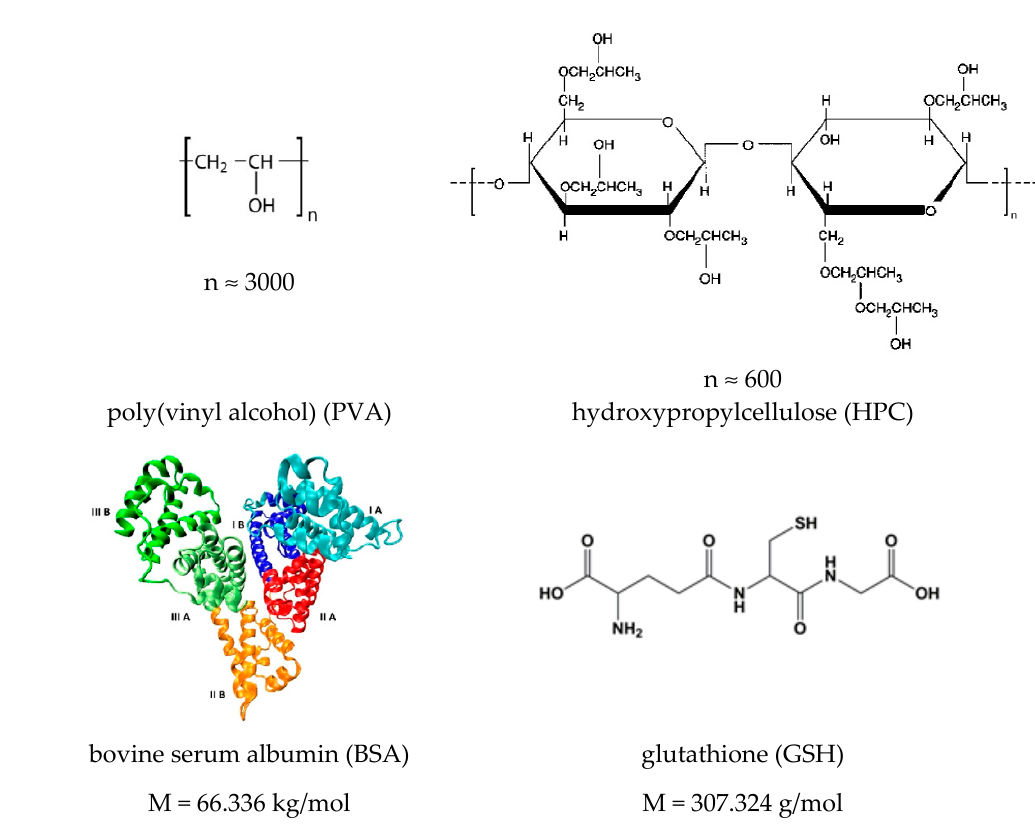
Scheme 1. Structure of polymers, protein and tripeptide used for hydrogel preparation. The structural subdomains of BSA are displayed with different colors (Reprinted with permission from Ref. [50] copyright 2012 Elsevier Ltd.). Table 1. Sample specifications and composition *, γ i (the strain at which G ′ = G ″ in amplitude sweep test) and tan δ (at 37 °C, 1 rad/s).